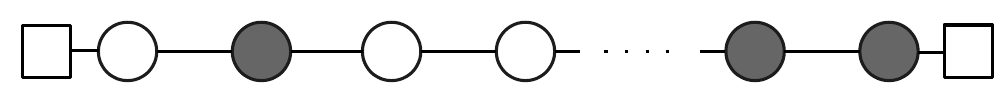
Figure 2 . General linear quiver in [55]. Shaded (unshaded) circles represent SU( N ), N = 1 ( N = 2) vector multiplets. Lines between them represent bifundamentals of SU( N ) (cid:2) SU( N ). The boxes at the two ends represent SU( N )